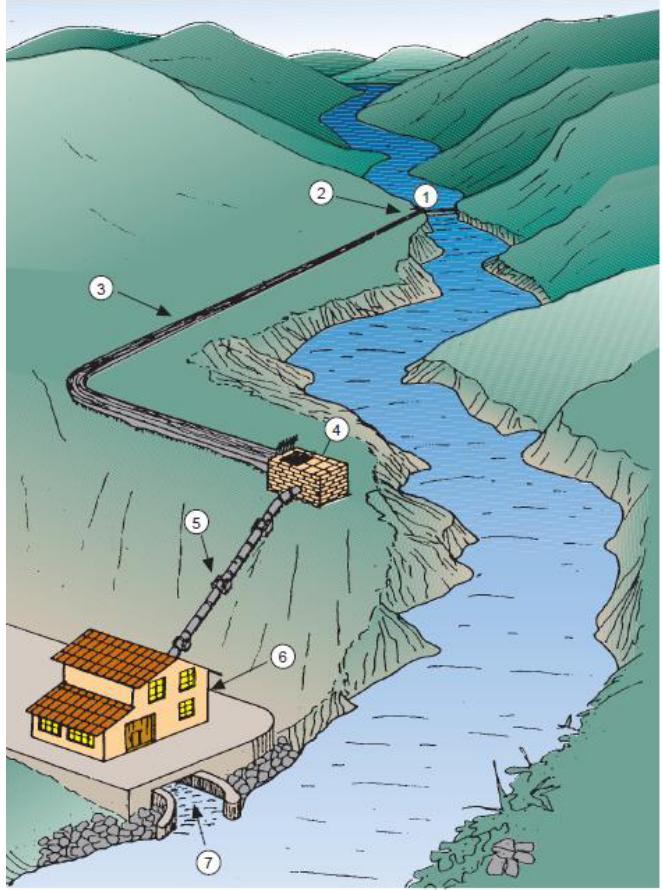
Figure 1. Run of River Scheme: (1) Diversion Weir, (2) Intake, (3) Headrace, (4) Surge Tank, (5) Pen- stock, (6) Powerhouse, (7) Tail Race